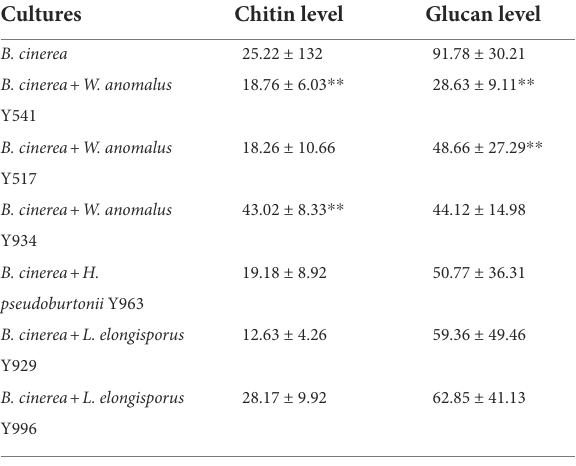
TABLE 3 Chitin and glucan content in Botrytis cinerea hyphae treated with various yeast strains capable of producing chitinase and glucanase.